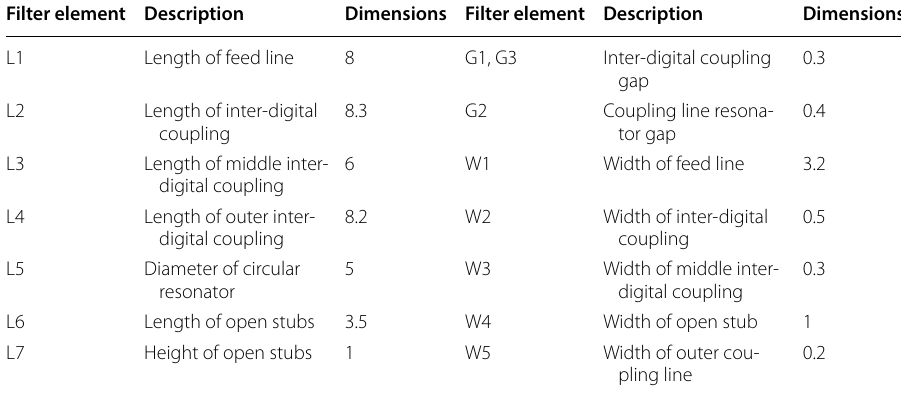
All dimensions are in mm